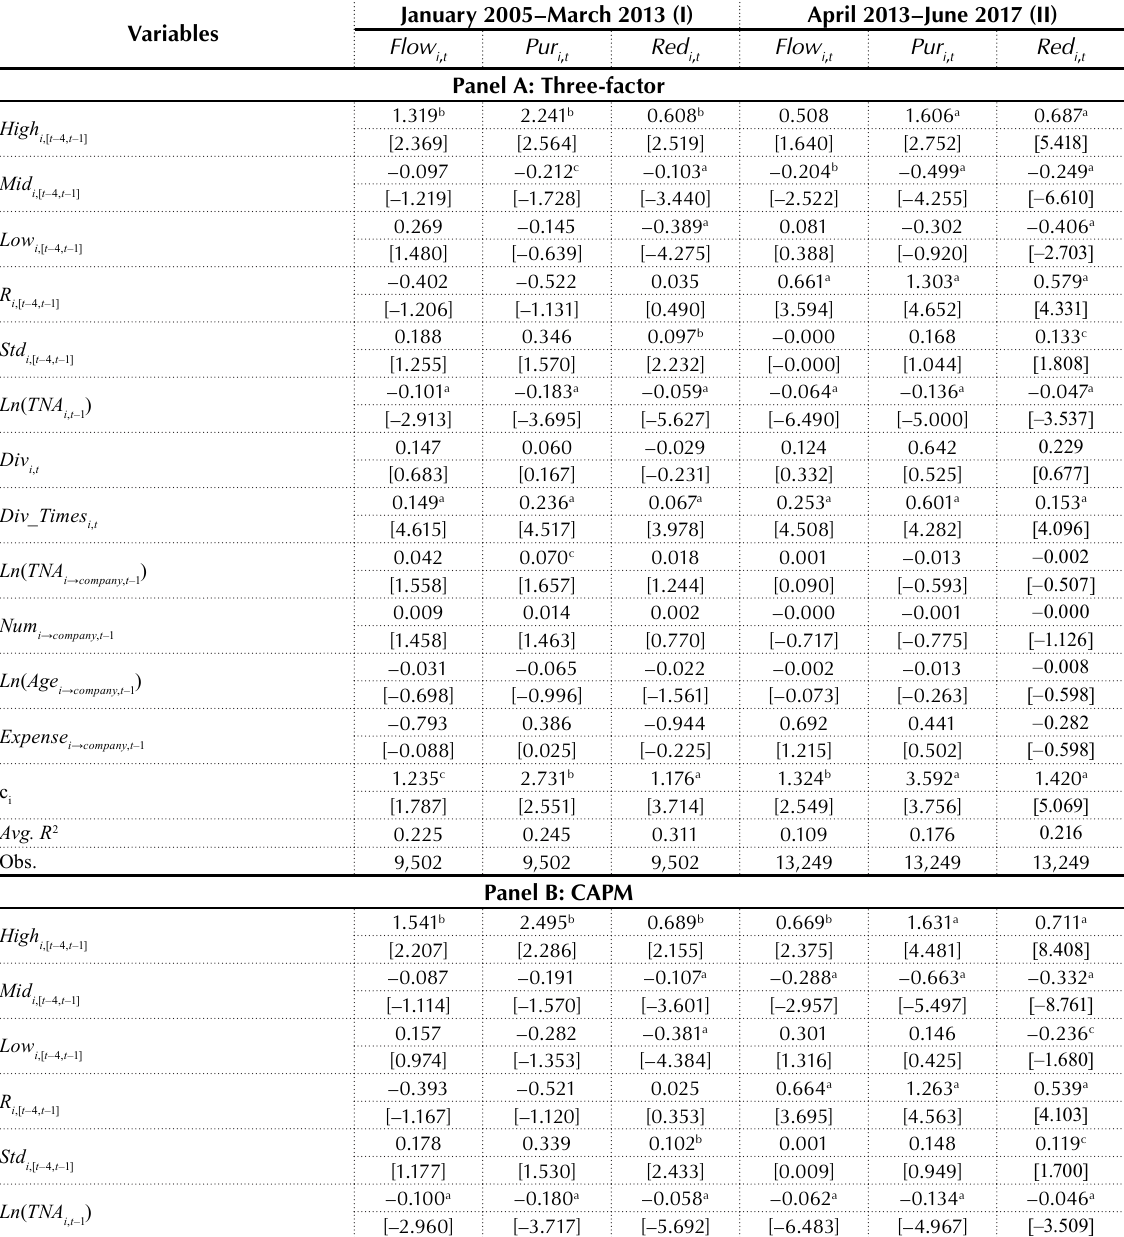
Table 8. Robustness test on two subperiods: the adoption of tradable